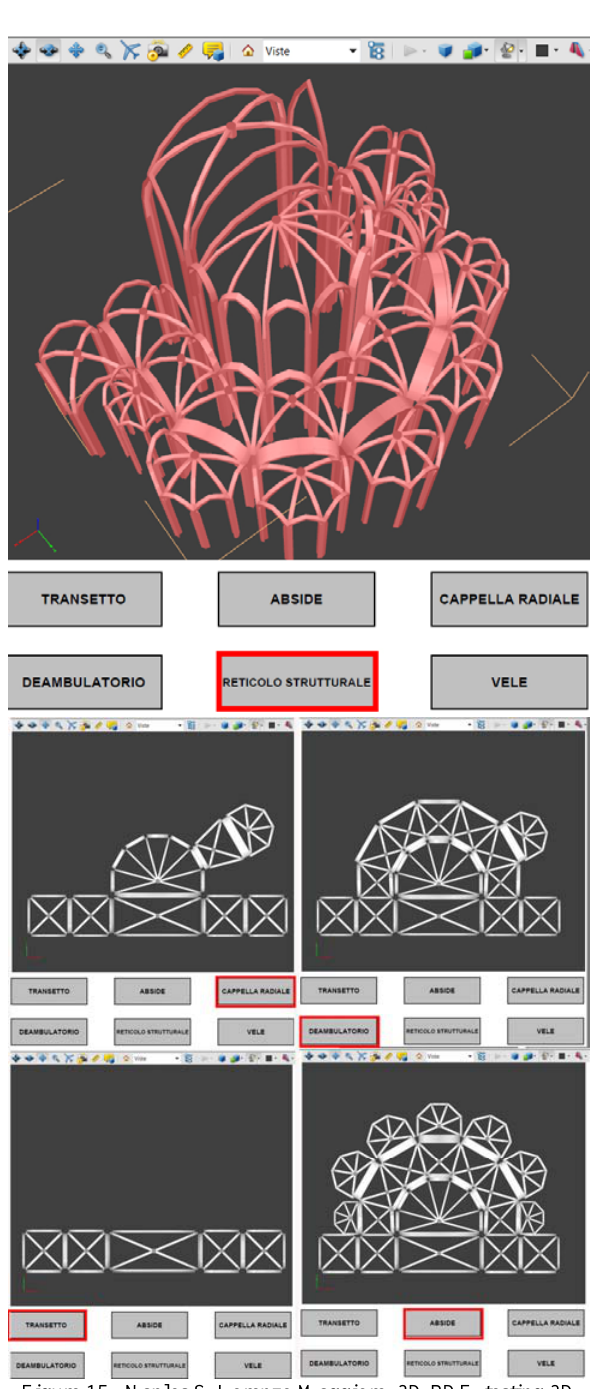
Figure 15 . Naples S. Lorenzo Maggiore. 3D PDF: testing 3D